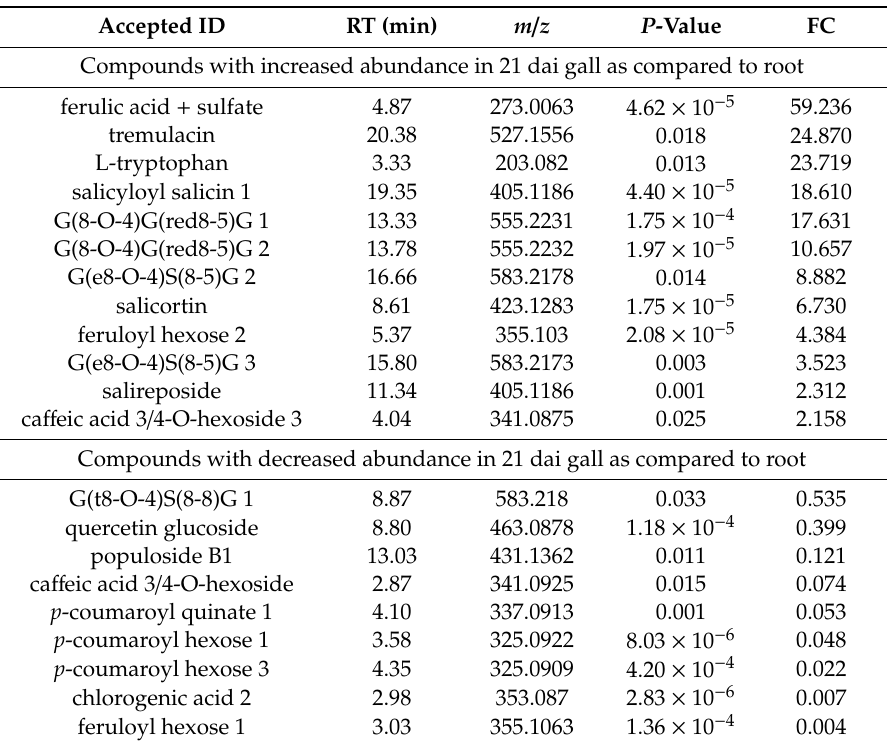
Table 5. List of putatively structurally characterised metabolites with a di ff erent abundance in 21 dai galls versus uninfected